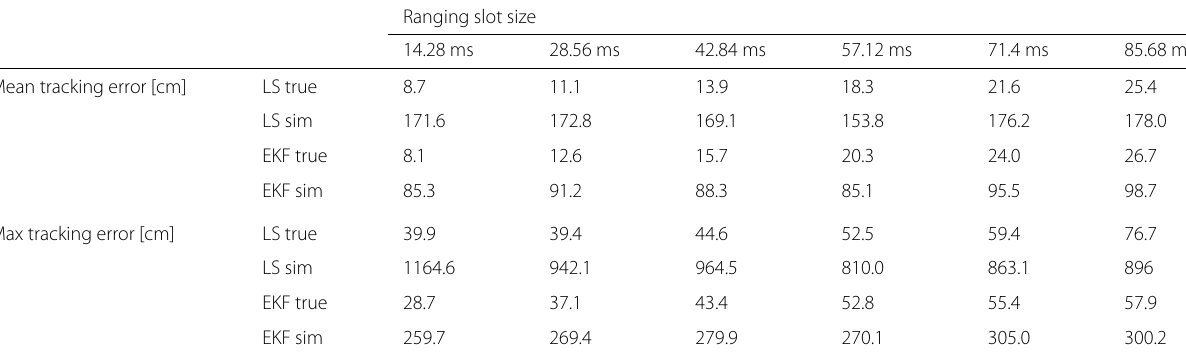
Table 1 Mean and maximum values of tracking errors obtained by the LS and EKF algorithms with simulations and